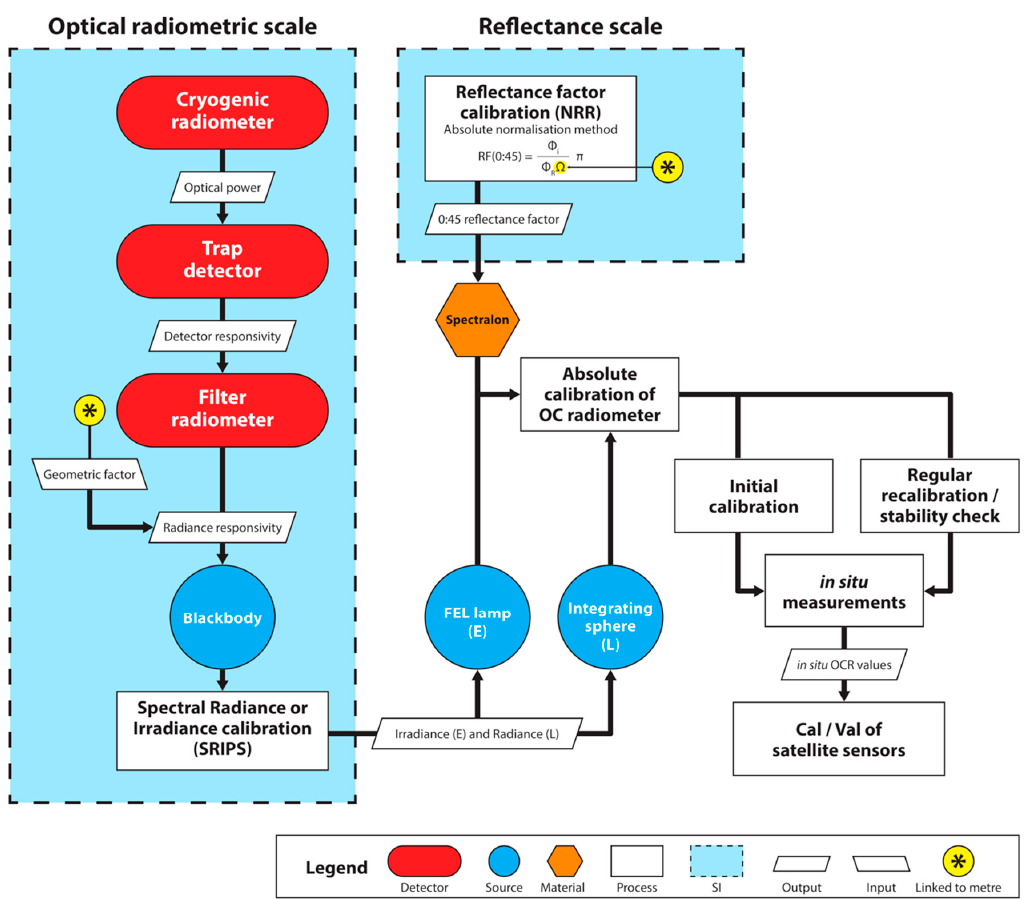
Figure 4. Simplified SI traceability chain at NPL for satellite ocean colour validation.